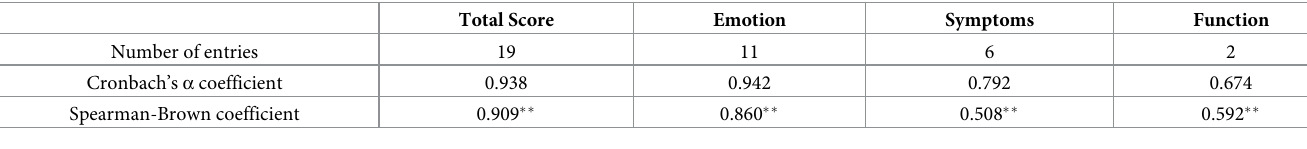
Table 4. Cronbach’s alpha for the adjusted RosQol (n = 265). Total Score Emotion